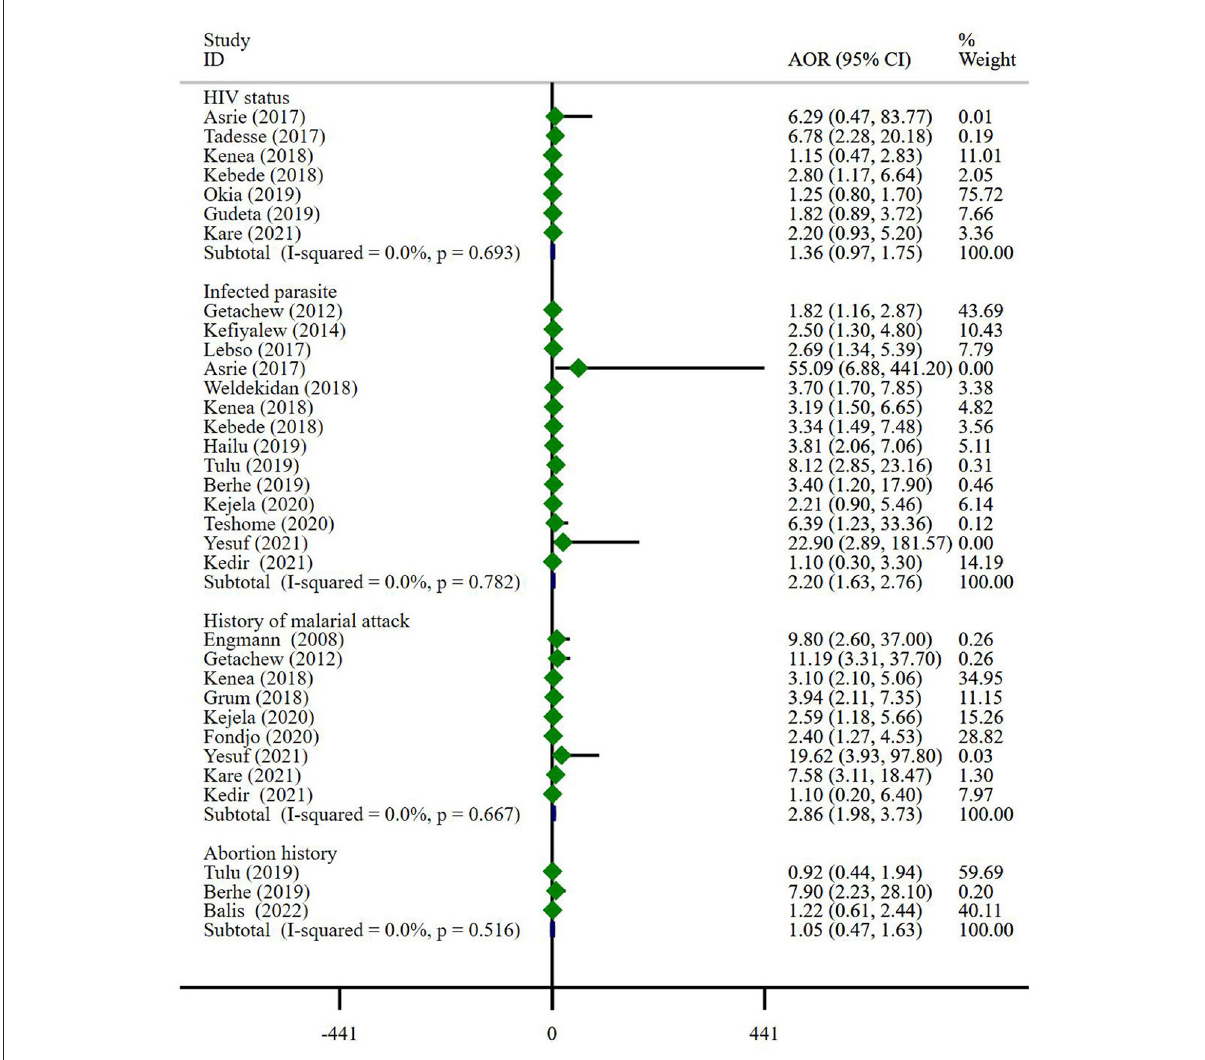
FIGURE2 Exposure factors associated with maternal medical